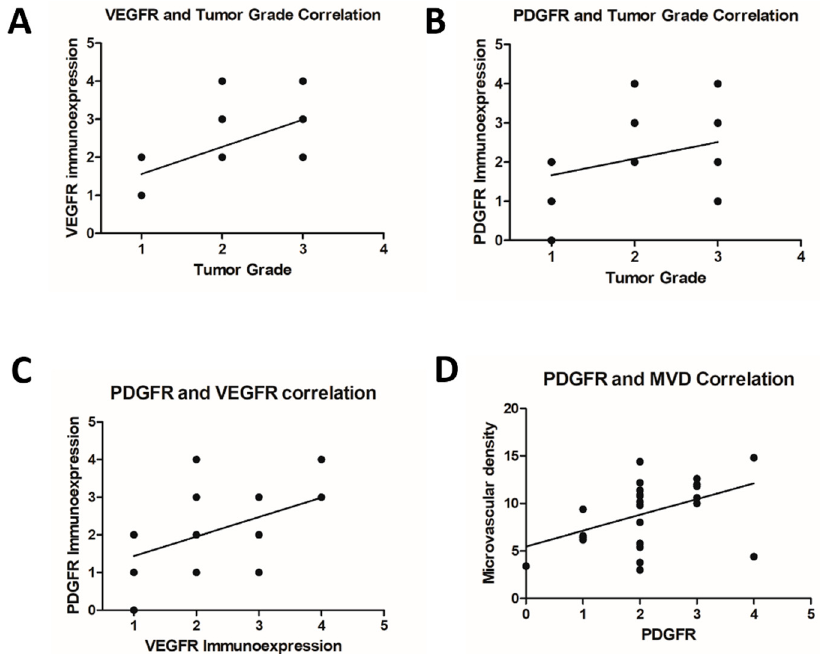
Figure 4. Correlation between immunohistochemical markers and different clinical parameters. ( A ) Positive correlation between VEGFR-2 immunoexpression and tumor grade ( p = 0.001; Spearman R = 0.6071). ( B ) Absence of correlation between PDGFR expression and tumor grade ( p = 0.0692; Spearman R = 0.3620). ( C ) Positive correlation between VEGFR-2 and PDGFR expression ( p = 0.01; Spearman R = 0.4959). ( D ) Positive correlation between PDGFR expression and microvascular density ( p = 0.0102; Spearman R = 0.4946).